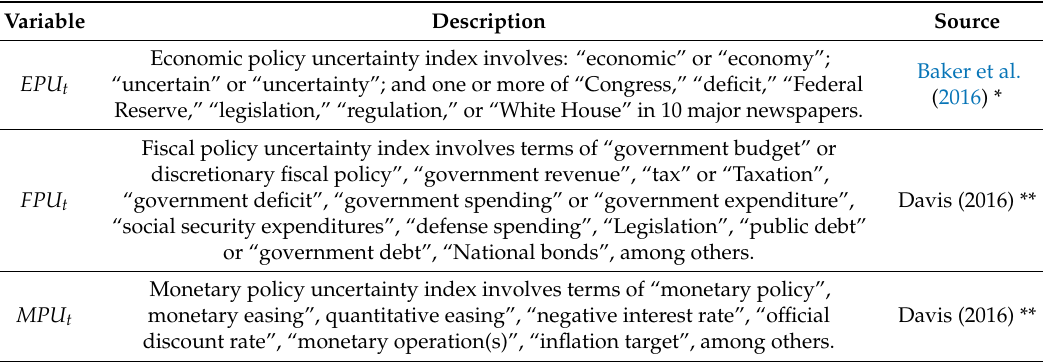
Table A1. Some major term sets for policy category uncertainty